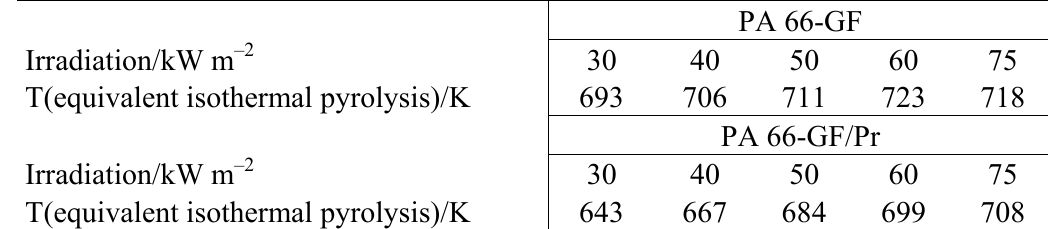
Table 3. Equivalent decomposition temperatures for PA 66-GF and PA 66-GF/Pr for forced-flaming combustion in the cone calorimeter at various irradiations. The equivalent decomposition temperature is the temperature of an isothermal thermogravimetric experiment resulting in the same mass